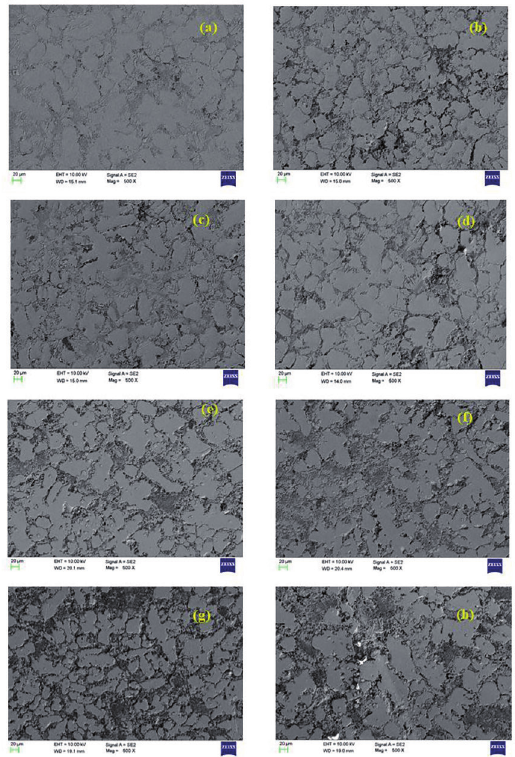
Figure 6. SEM images of (a) 3% Garnet with chill, (b) 3% Garnet with No chill, (c) 6% Garnet with chill, (d) 6% Garnet with No chill, (e) 9% Garnet with chill, (f) 9% Garnet with No chill, (g) 12% Garnet with chill, (h) 12% Garnet with No chill.